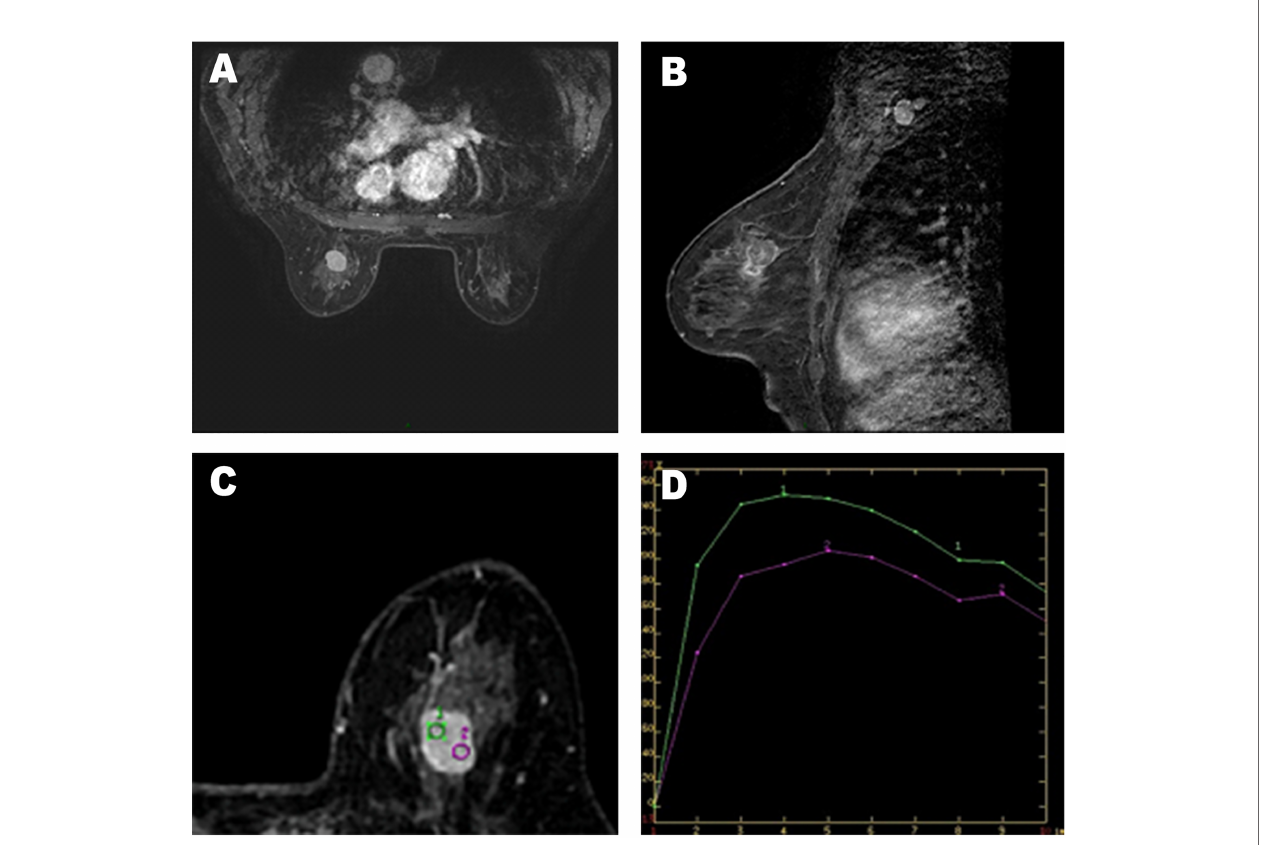
FIGURE 2 | (A – C) Axial and sagittal contrast-enhanced MR image shows rapid and heterogeneous tumor enhancement. (D) Dynamic contrast-enhanced magnetic resonance imaging (MRI) demonstrated a time – signal intensity curve (TIC) with a rapid rise to a peak (after the administration of the contrast material), followed by a slow-out at the